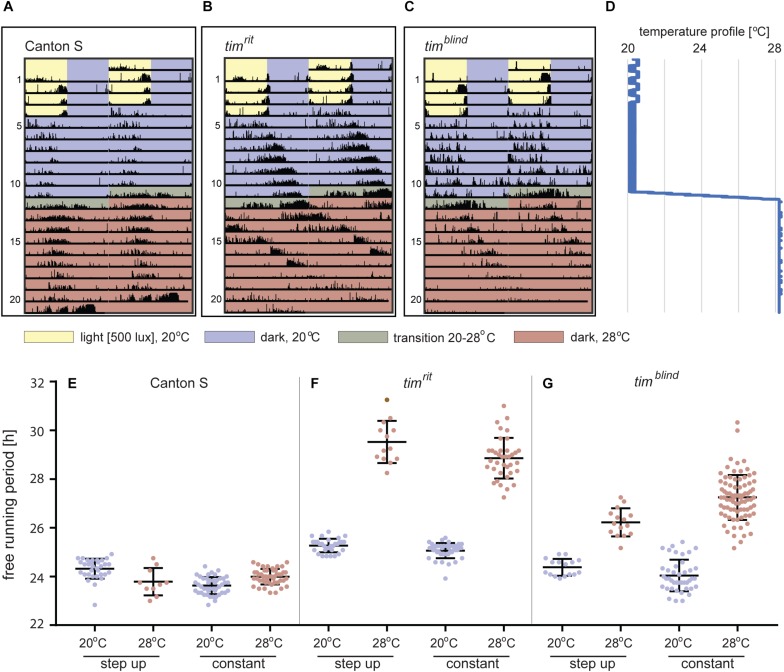
Locomotor activity of D. melanogaster at different temperatures. (A–C) Typical double-plotted actograms obtained during the step-up protocol consisting of 4-day LD entrainment at 20°C followed by 7 days of DD at 20°C. Then, temperature was raised to 28°C during 16 h (1°C every 2 h) and kept constant for the rest of the experiment. (D) Temperature profile recorded during the step-up protocol (note small thermoperiodic oscillations typical for LD conditions). (E–G) Comparison of the free running periods (τ) measured at low and high portions of the step-up protocol, respectively, with data obtained from flies entrained and recorded at one constant temperature. Each dot corresponds to FRP of individual male fly, and colors correspond to the temperature-coding used in actogram backgrounds. Not all males survived entire step-up experiment (note lower n at 28°C). Bars show the mean ± SD.